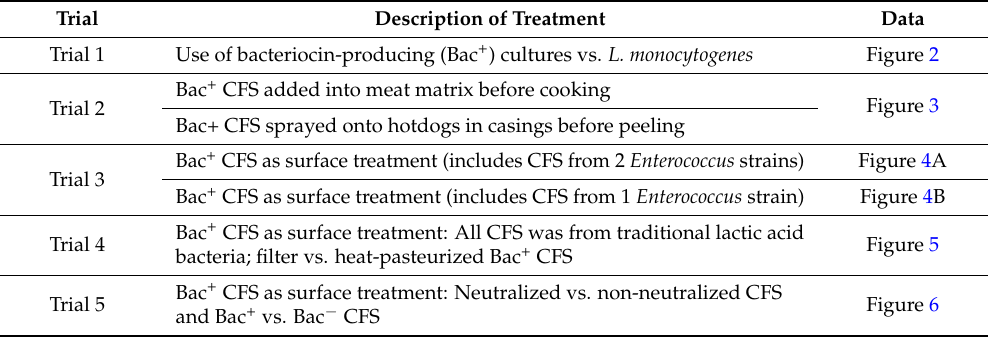
Table 2. Description of trials and treatments used in this study applying bacteriocin-producing cultures (Bac + ) or their cell free supernatants (CFS) to inhibit L. monocytogenes on RTE